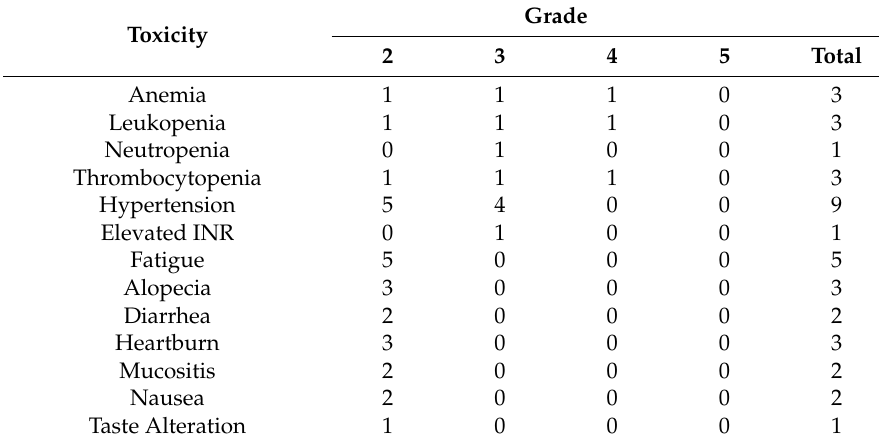
Table 2. Adverse events possible, probable, or definitely attributable to bevacizumab or valproic acid, all cycles.